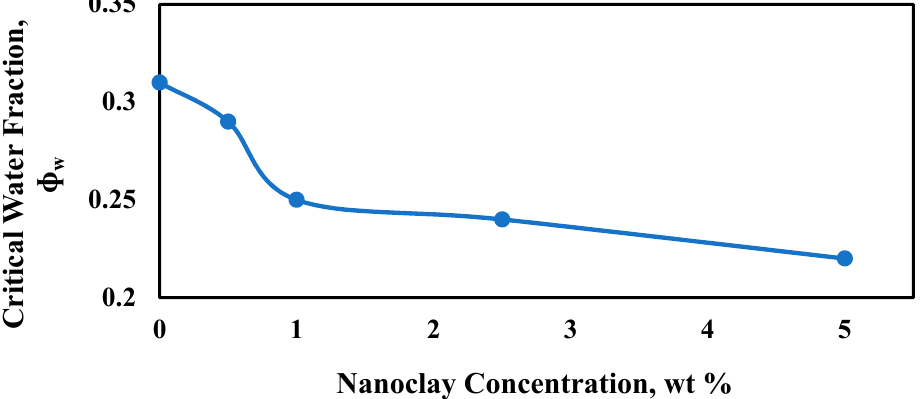
Figure 10. Critical volume fraction of water versus nanoclay concentration.